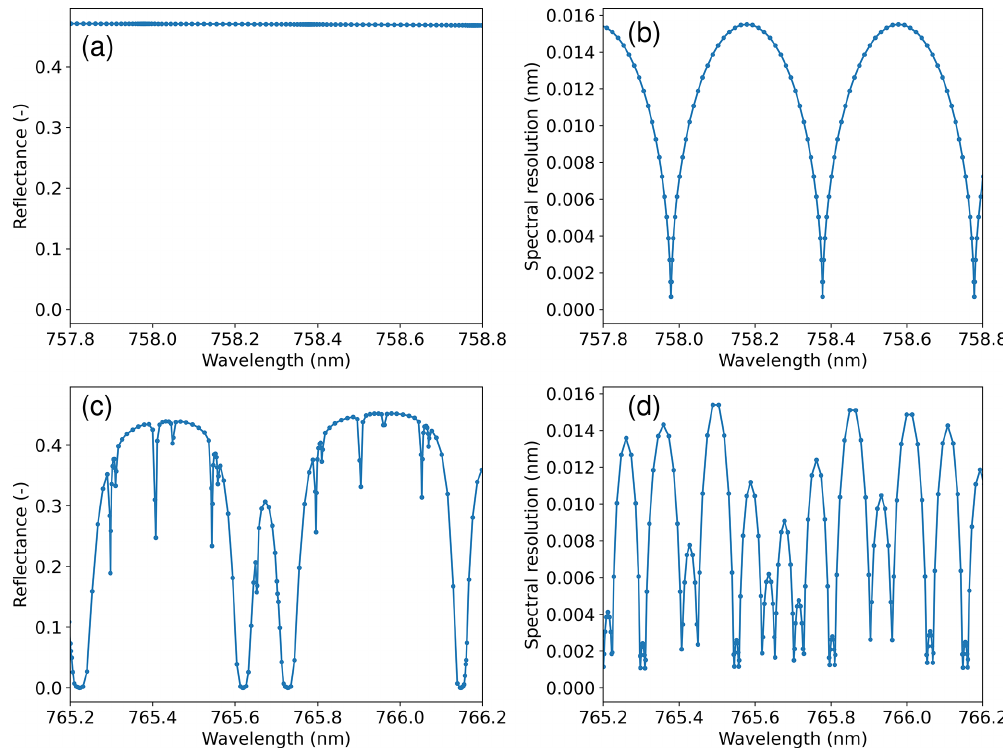
Figure 1. Illustration of the wavelength grid used in DISAMAR. (a) Simulated reflectance spectrum at the top of the atmosphere in the continuum part of the oxygen A-band, from 757.8–758.8nm, at a Gaussian wavelength grid. (b) Wavelength grid interval distribution for the spectrum of (a) . Panels (c, d) are similar to panels (a, b) but for the oxygen A-band absorbing part, i.e. 765.2–766.2nm. In determining the Gaussian wavelength grid, the positions of the absorption lines are taken into account. The number of Gaussian division points is 40 and the minimum number is